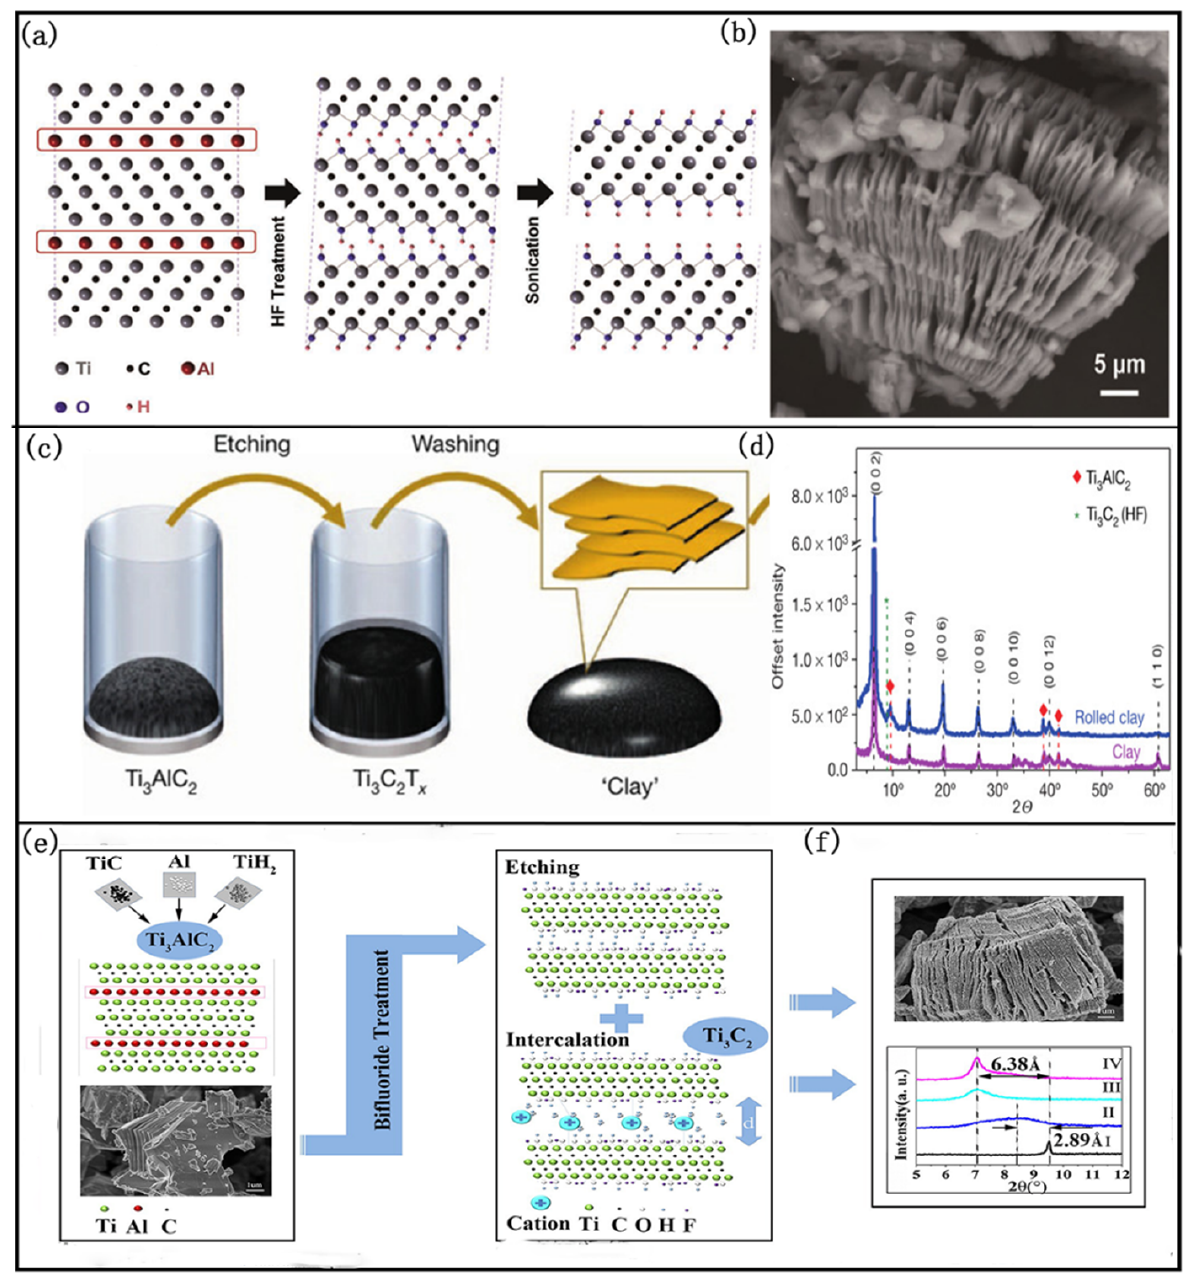
Figure 1. ( a ) Schematic of the exfoliation process for Ti 3 AlC 2 . ( b ) SEM image of a sample after HF treatment. Reprinted with permission from Ref. [73]. Copyright 2011 WILEY-VCH Verlag GmbH & Co., KGaA. ( c ) Ti 3 AlC 2 etched in a solution of HCl + LiF and then washed with water to obtain Ti 3 C 2 T x ; the resulting Ti 3 C 2 T x behaves like a clay. ( d ) XRD patterns of samples produced by etching in LiF + HCl solution. Reprinted with permission from Ref. [77]. Copyright 2014 Nature . ( e ) The schematic illustration of a reaction between Ti 3 AlC 2 and bifluorides. ( f ) SEM images of samples exfoliated by NH 4 HF 2 and the XRD patterns of Ti 3 AlC 2 and different Ti 3 C 2 samples: (I) Ti 3 C 2 from etching Ti 3 AlC 2 with HF; (II) Ti 3 C 2 from etching Ti 3 AlC 2 with NaHF 2 ; (III) Ti 3 C 2 from etching Ti 3 AlC 2 with KHF 2 ; (IV) Ti 3 C 2 from etching Ti 3 AlC 2 with NH 4 HF 2 . Reprinted with permission from Ref. [78]. Copyright 2017 Materials & Design